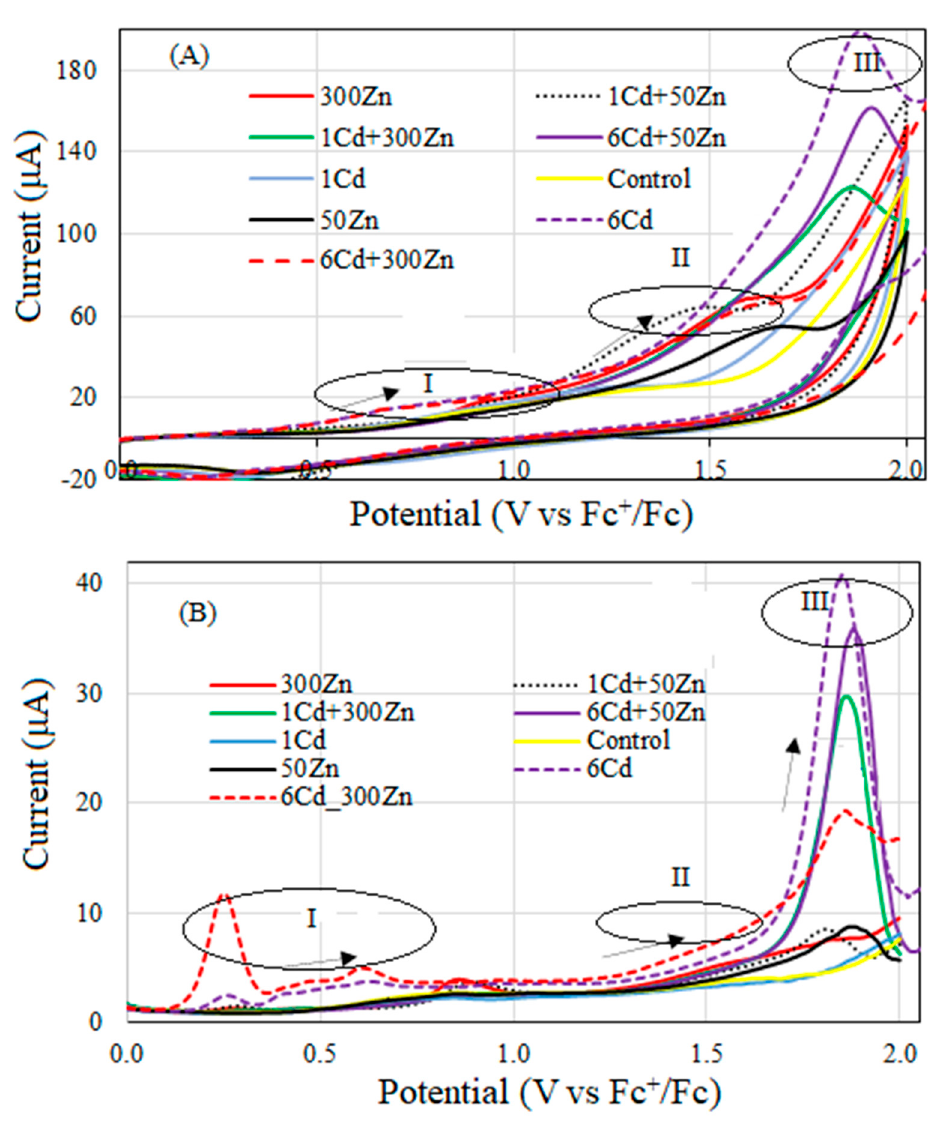
Figure 3 . Cyclic ( A ) and differential pulse voltammetry ( B ) voltammograms for lemon balm extracts on Pt electrodes in 0.1 M (C 4 H 9 ) 4 NClO 4 . The former were collected with the scan rates v = 0.1 V s − 1 and v = 0.01 V s − 1 . Modulation amplitude 25 mV and pulse of 50 ms were applied for the latter. Table 2. Electrochemical indices (EI) determined by CV and DPV methods for lemon balm extracts.